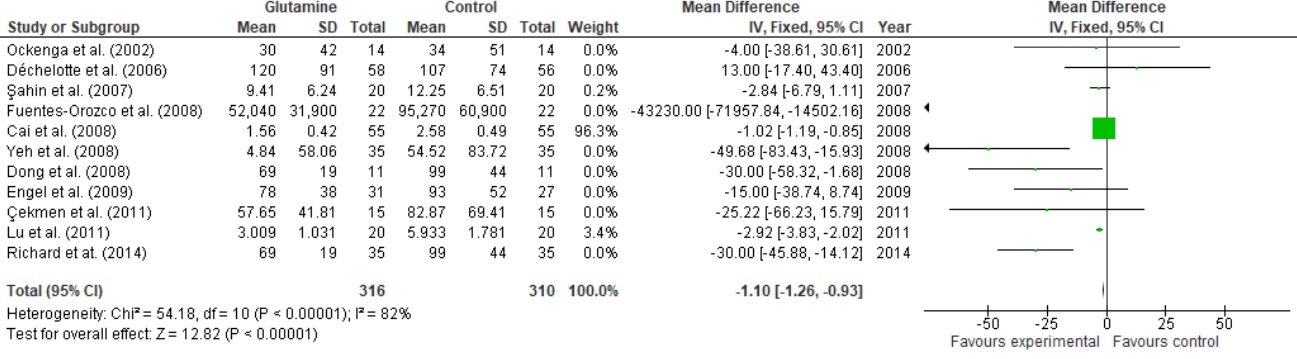
Figure 13. C-reactive protein: fixed-effects meta-analysis and forest plot from studies providing supplementation of glu- tamine.